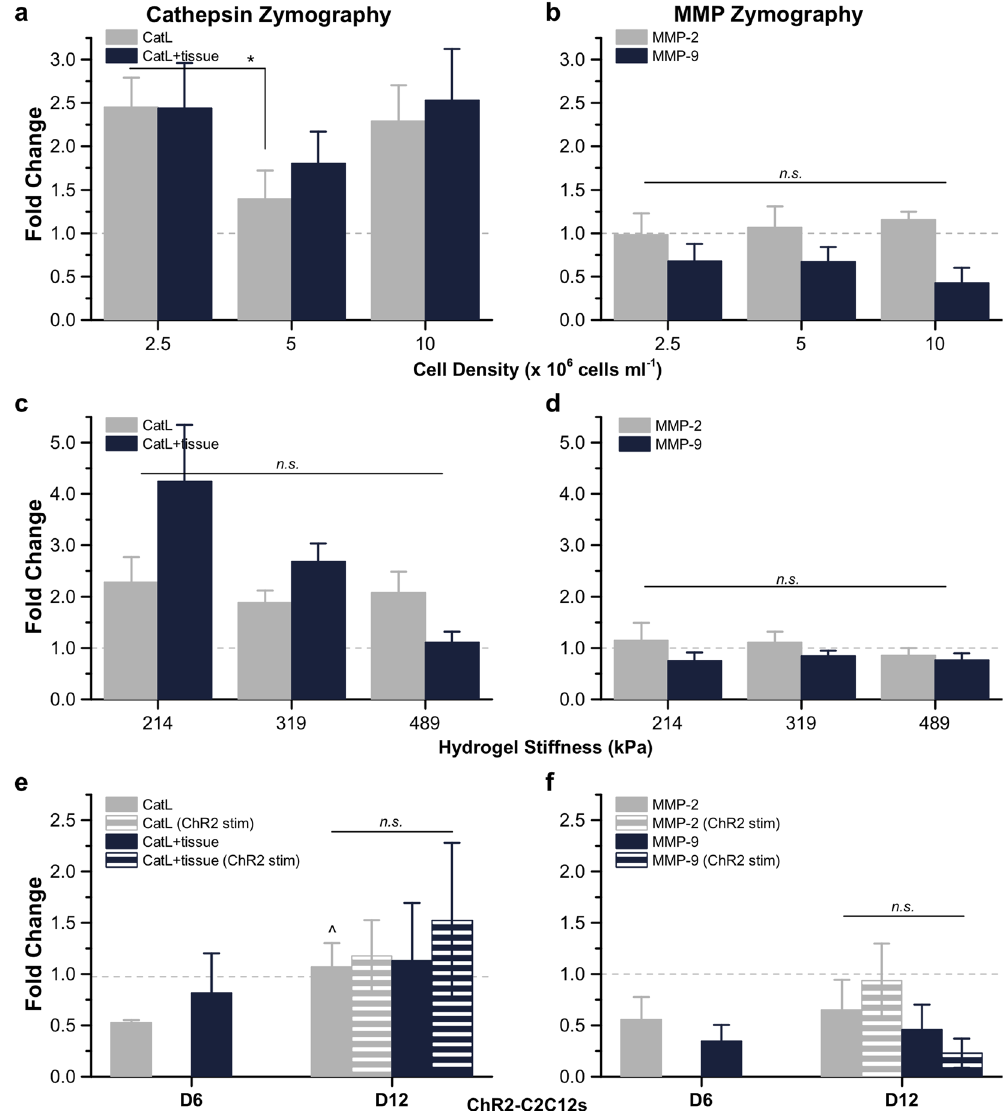
Figure 7. Gelatin Zymography of Cathepsins and MMPs in Muscle Strips with Varying Cell Density, Hydrogel Skeleton Stiffness and Applied Stimulation. ( a ) For day 12 muscle strips cultured with 1x ACA and fabricated with varying cell densities (2.5, 5, or 10 × 10 6 cells ml − 1 ), cathepsin zymography identified the amount of active CatL and CatL + tissue and ( b ) MMP zymography identified the amount of active MMP-2 and MMP-9 ( n = 7 − 10 muscle strips per condition). ( c ) For day 12 muscle strips cultured with 1x ACA with a hydrogel skeleton stiffness of 214, 319, or 489 kPa, cathepsin zymography identified the amount of active CatL and CatL + tissue and ( d ) MMP zymography identified the amount of active MMP-2 and MMP-9 ( n = 9 − 17 muscle strips per condition). ( e ) For ChR2-C2C12 optogenetic muscle strips, cathepsin zymography identified the amount of active CatL and CatL + tissue at days 6 and 12 and ( f ) MMP zymography identified the amount of active MMP-2 and MMP-9 at days 6 and 12, in the presence or absence of optogenetic stimulation ( n = 3 muscle strips per condition). All plots represent mean ± SEM. * indicates significance ( p < 0.05) between conditions at the same time point; ^ indicates significance compared to initial time point (day 6 for panels (e and